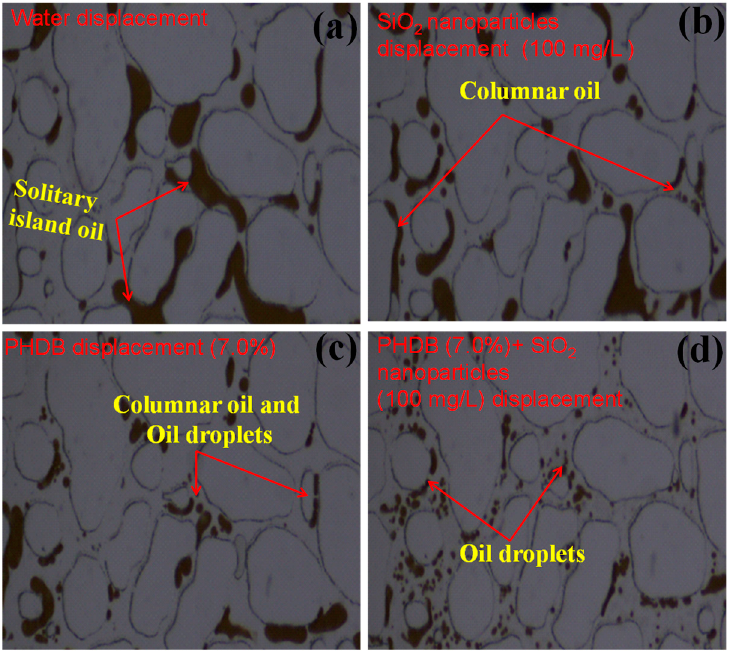
Figure 5. Mobilization characteristics of residual oil in excessive areas under different displacement fluids. ( a ) After water flooding, ( b ) 100 mg/L of SiO 2 nanoparticle displacement, ( c ) 7.0% of PHDB displacement, and ( d ) PHDB (7.0%)-SiO 2 nanoparticles (100 mg/L) composite displacement.